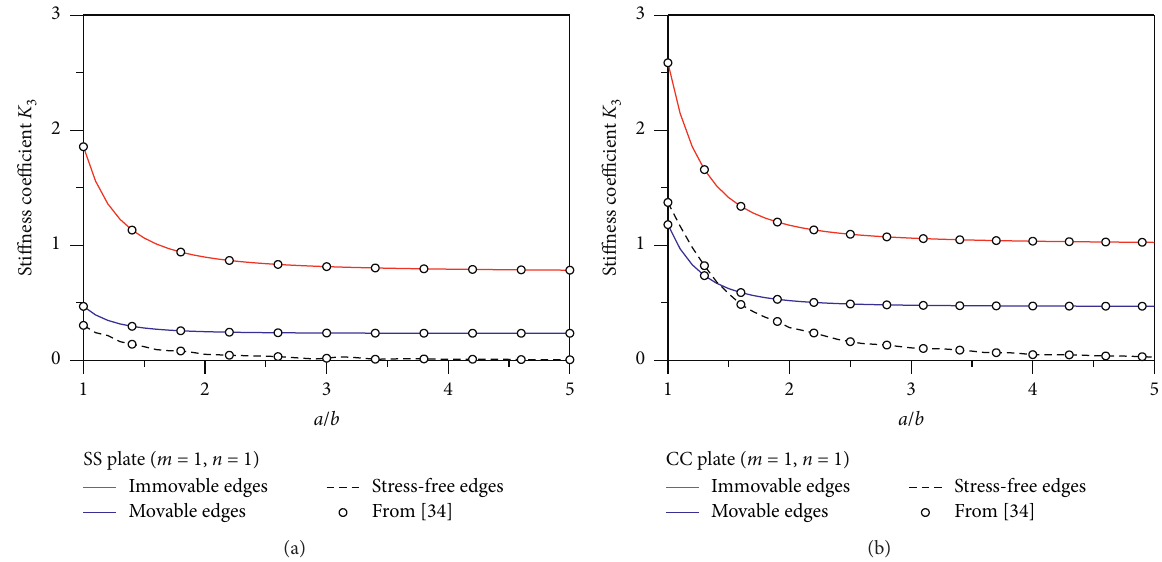
� 1 and n � 1 for (a) SS and (b) CC 3 ) as a function of a / b , as obtained with m